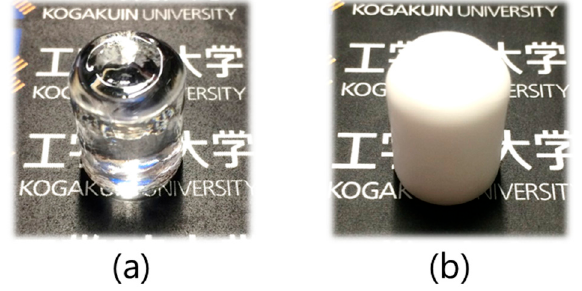
Figure 3. Photographs of original glass ( a ) and crystallized glass-ceramics ( b ) of Narpsio.